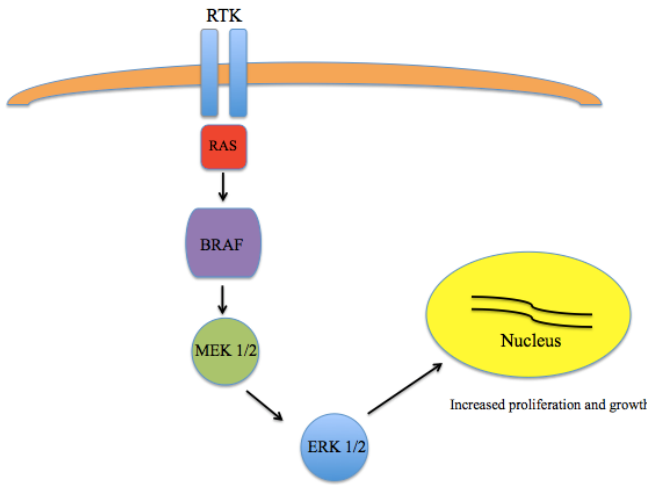
Figure 1. Mitogen Activated Protein Kinase (MAPK) pathway signaling. The RAS-RAF-MEK-ERK pathway transmits signals from extracellular ligands to specific intracellular effectors. Mutations in BRAF results in a constitutively active kinase leading to unregulated growth and proliferation.